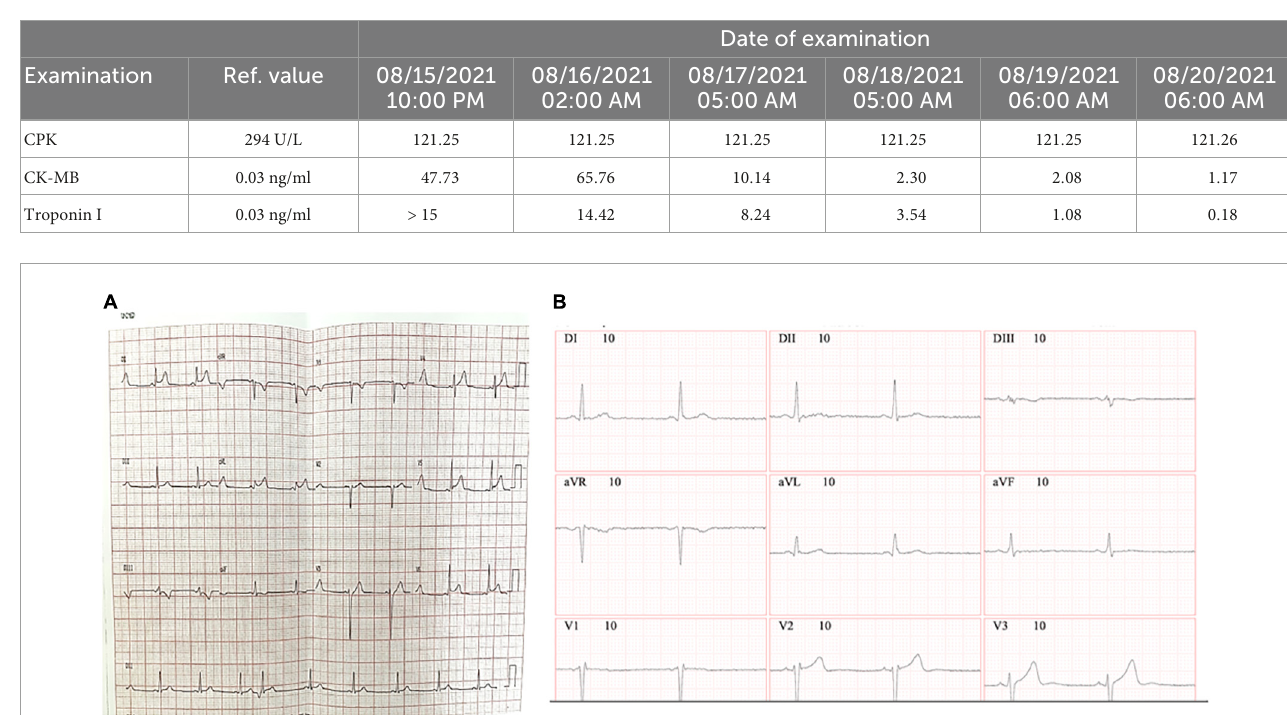
TABLE 1 Laboratory results of cardiac enzymes.